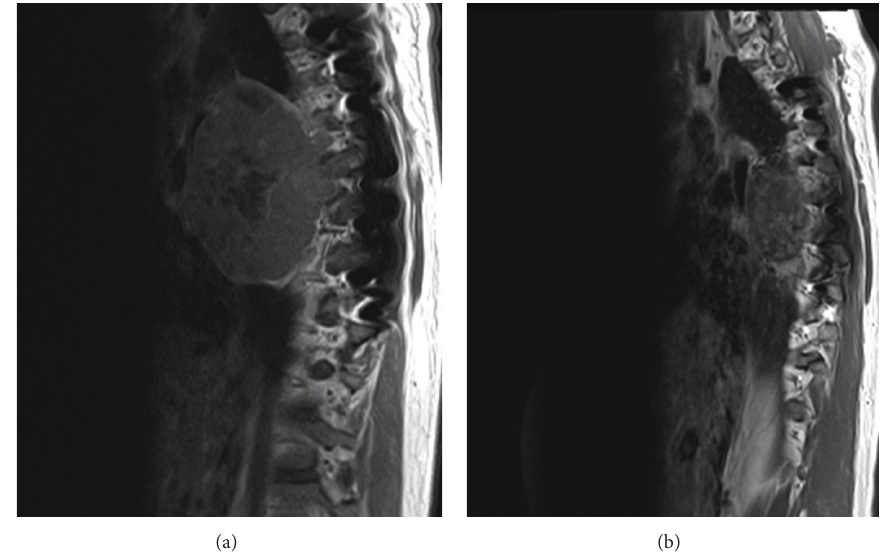
Figure 2: Sagittal T1 postcontrast computed tomographic images show the large mid-thoracic spine mass (a) before and (b) 10 months after denosumab therapy.